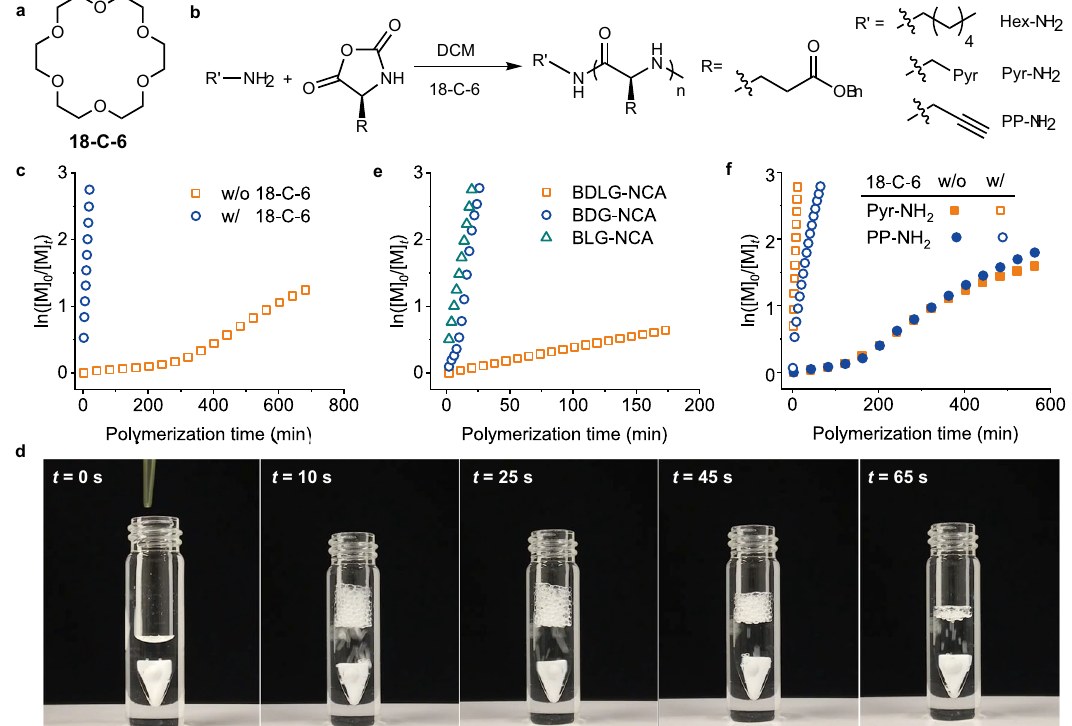
Fig. 1 CE-induced accelerated polymerization of NCA. a Chemical structure of 18-C-6. b Scheme illustrating CE-catalyzed polymerization of NCA from small-molecular amine initiators. c Semilogarithmic kinetic plot of polymerization of BLG-NCA in DCM initiated by Hex-NH 2 in the presence and absence of 18-C-6. [M] 0 /[I] 0 = 100, [I] 0 = [CE] 0 = 0.5 mM. d Snapshots showing the fast consumption of BLG-NCA accompanied with the rapid evolution of carbon dioxide at [M] 0 /[I] 0 = 100, [I] 0 = [CE] 0 = 4 mM. e Semilogarithmic kinetic plot of polymerization of BLG-NCA, BDG-NCA, and BDLG-NCA in DCM